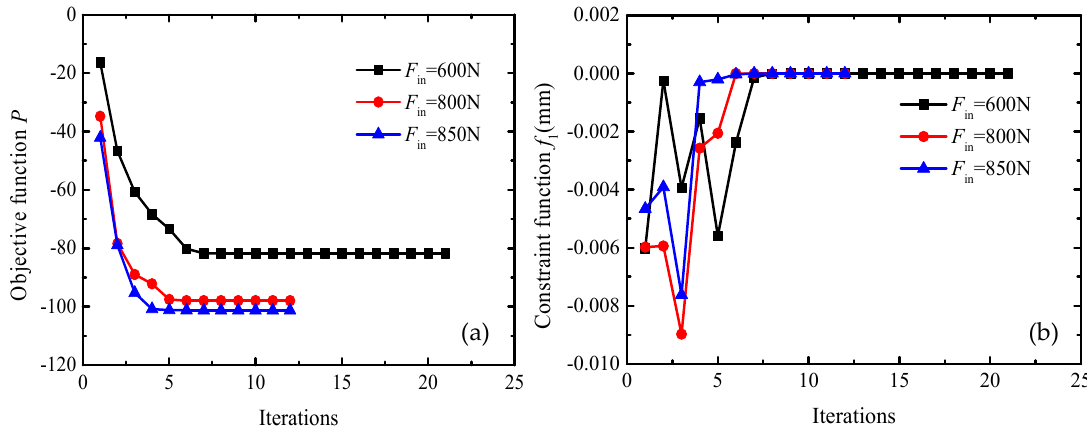
Figure 5. Iteration curves of the optimization process under a different input force. ( a ) The iteration curves of the optimization objective function P . ( b ) The iteration curves of a constraint function f 1 .